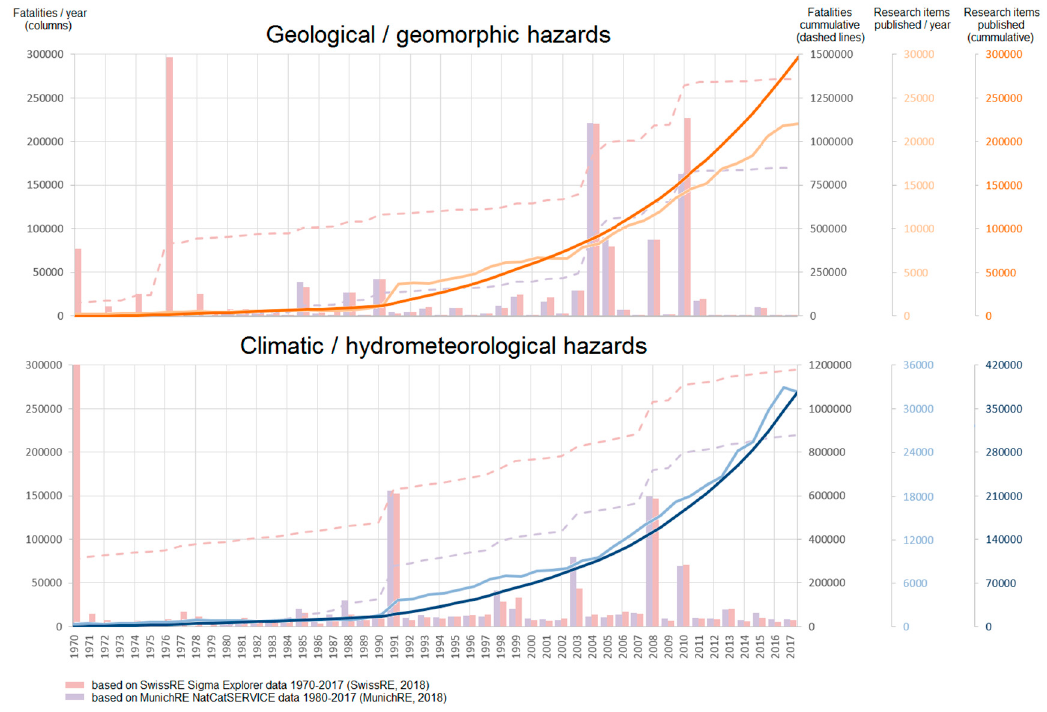
Figure 6. Research on geological/geomorphic and climatic/hydro-meteorological natural hazards and fatalities caused (fatalities estimations based on [1,5]).